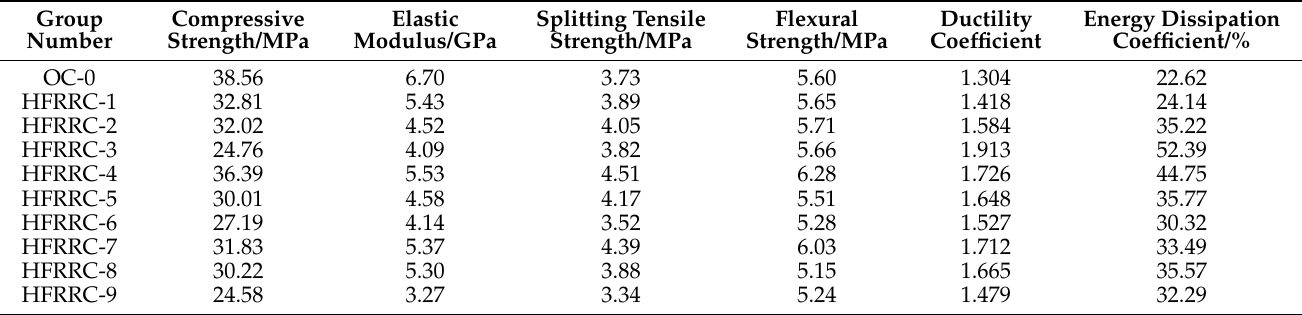
Table 9. Results of orthogonal